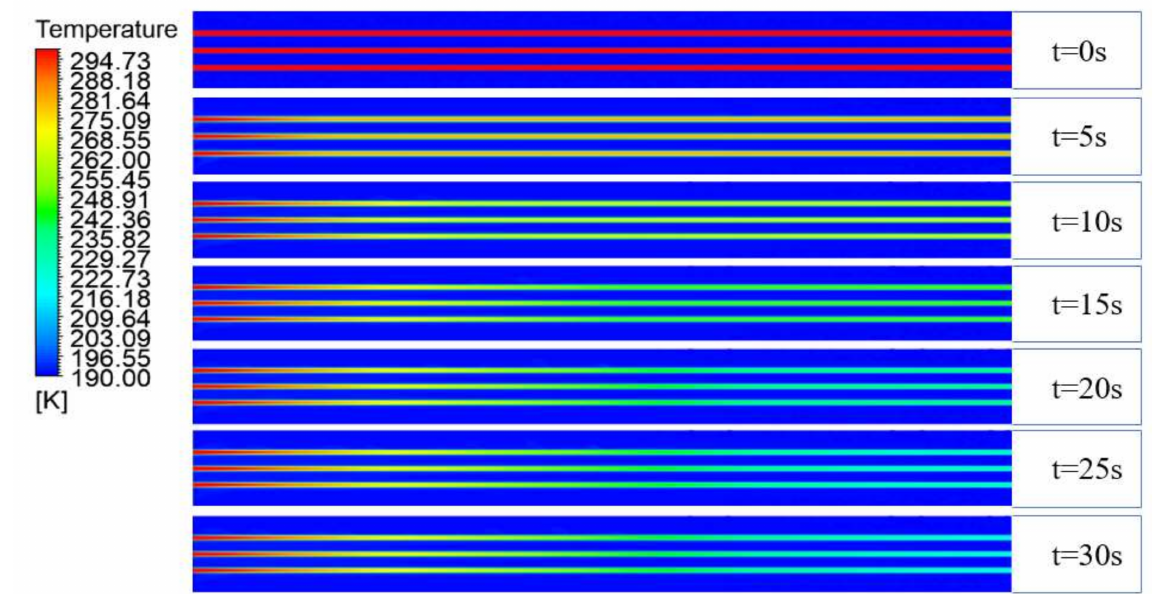
Figure 9. CFD simulation results in temperature cloud